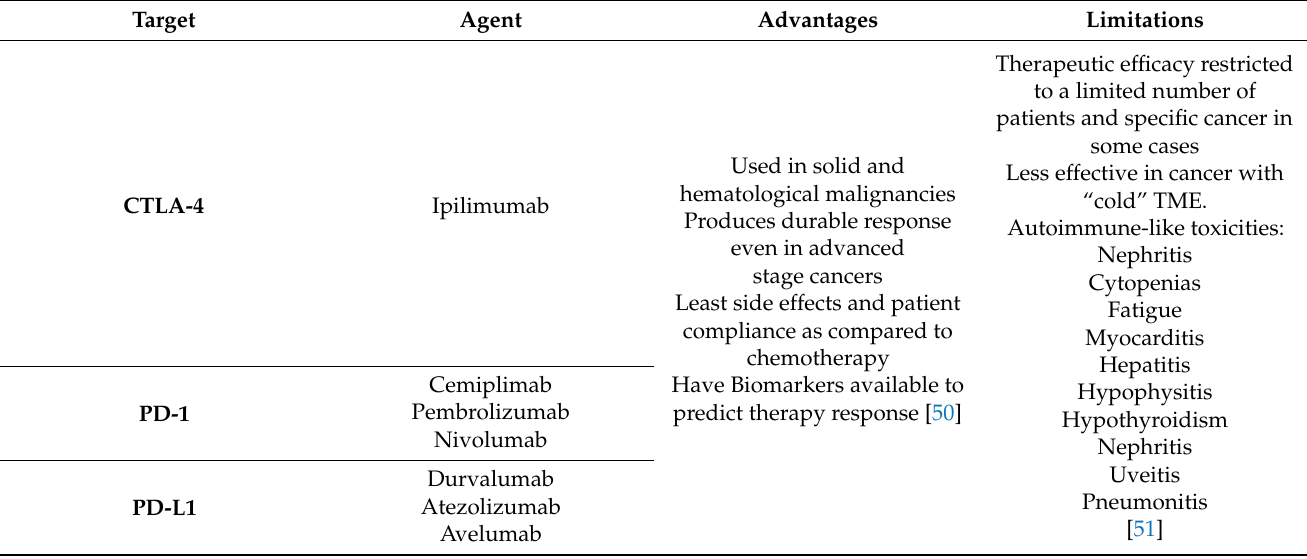
Figure 2. Immune checkpoint blockade therapy for suppression of cervical cancer. ( i ) Depicts immune evasion due to expression to immune checkpoint molecules. ( ii ) Shows action of immune checkpoint blocking molecule (such as pembrolizumab) that promotes T cell recognition and killing of tumor cells. Table 1. Immune checkpoint inhibitors for the treatment of cervical